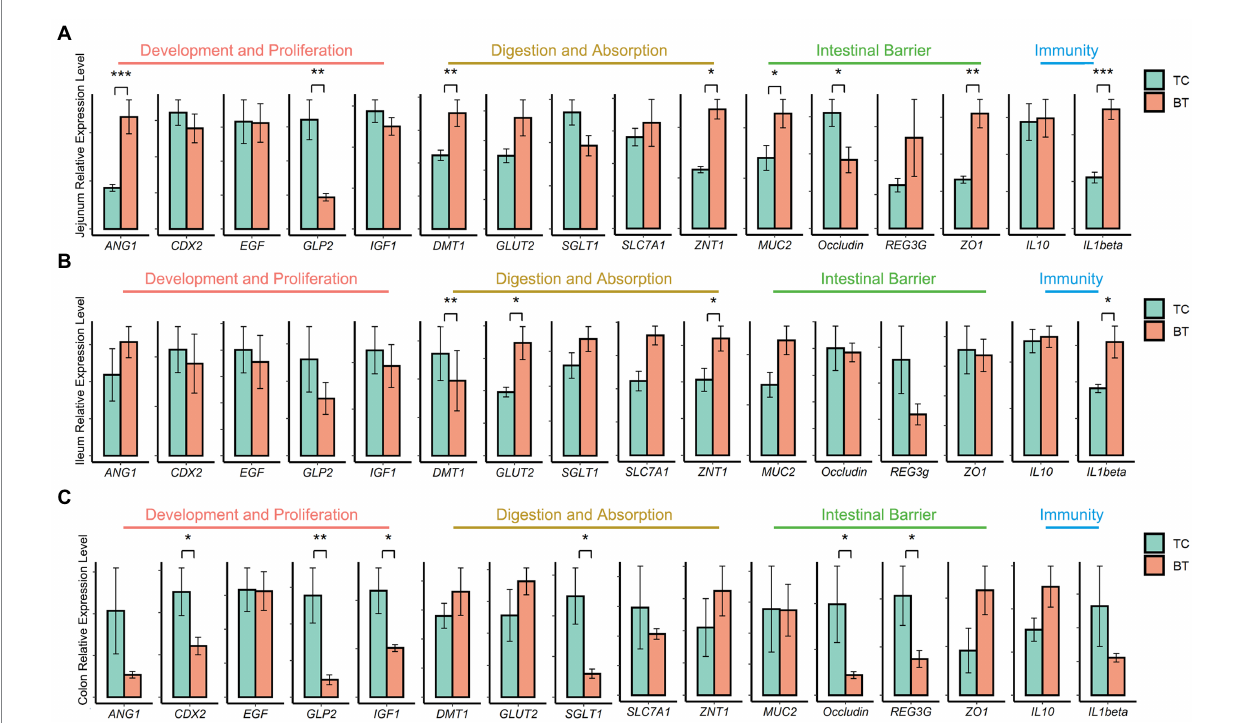
FIGURE 3 mRNA expression of genes related to intestinal functions was assessed by real-time PCR and normalized to beta-actin. The values showed in the bar are presented as means ± SEM, and differences in the figures were marked by “*” and “**” while p < 0.05 and p < 0.01, respectively. (A) mRNA expression